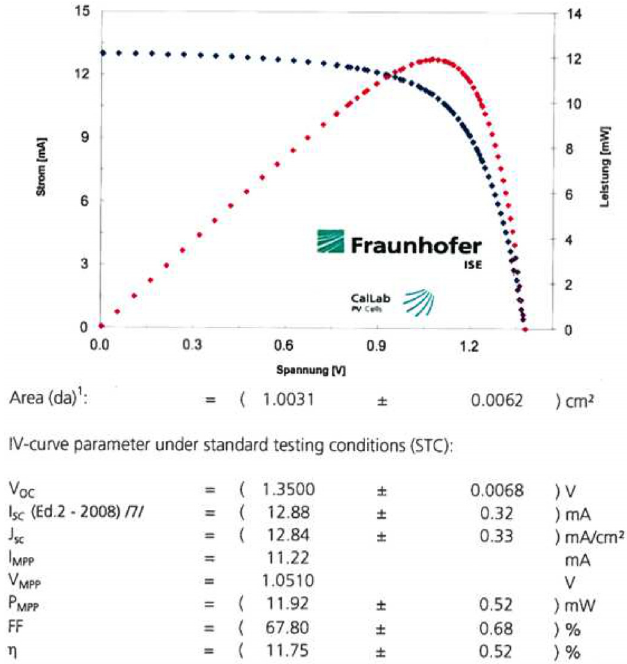
Fig. 4. IV curve of a micromorph cell with an efficiency of 11 . 75%, deposited using highly transparent ZnO